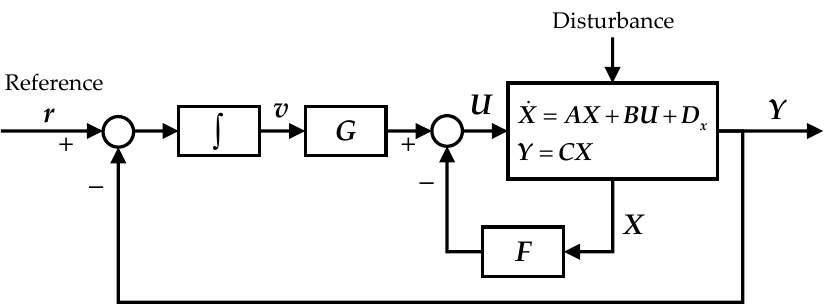
Figure 2. An integral-type servosystem for the 6-DoF AVIS.